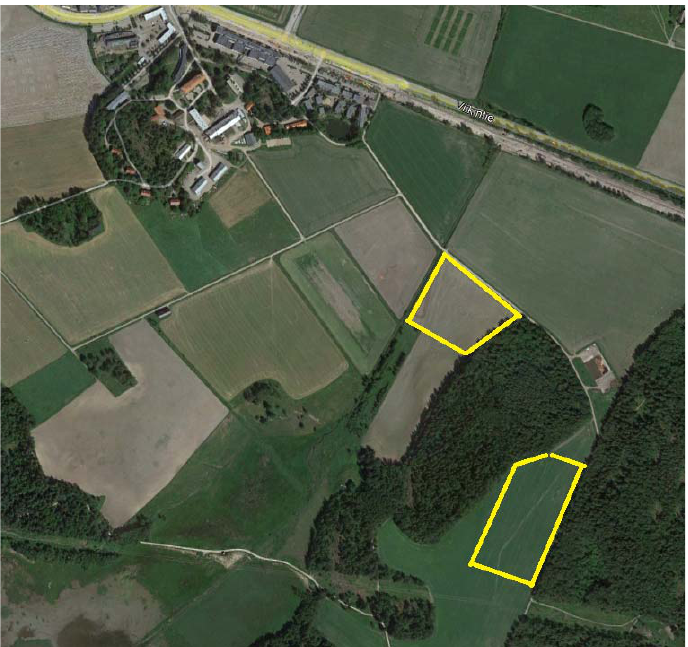
Figure 2. Research fields are marked with yellow stripes on the picture. The upper field is named Mölylä and the other field is Koirasuo. The picture is from Google Earth, June 2020.